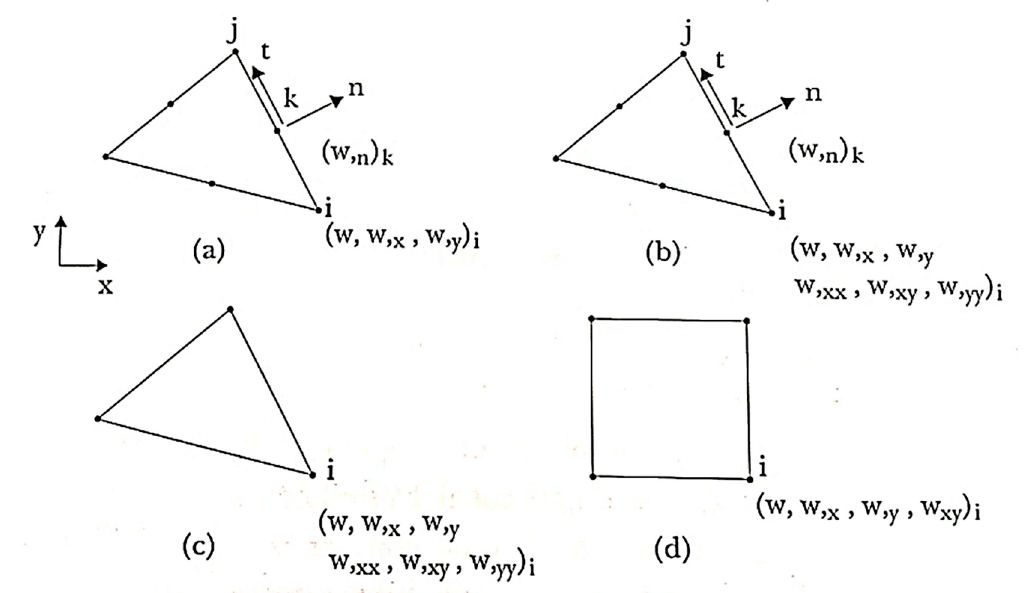
Figure 19. Compliant thin-plate elements. Reproduced with permission [75] .